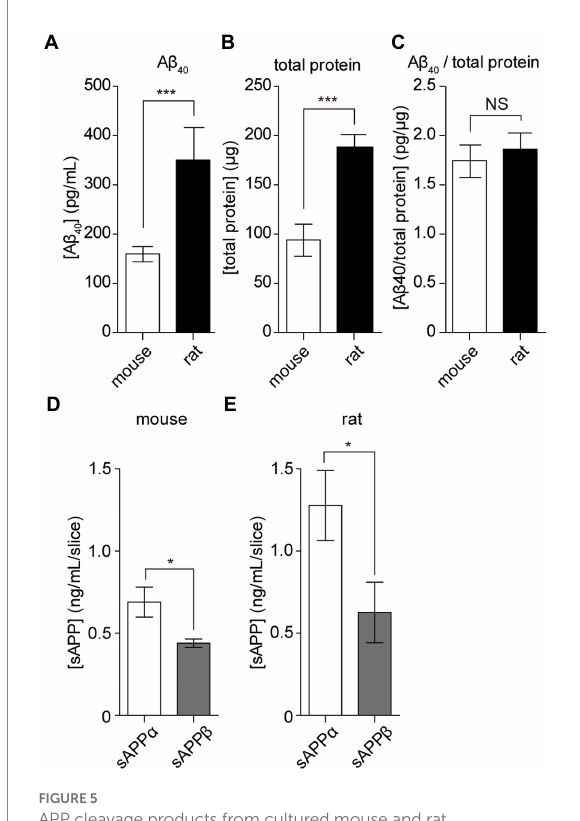
FIGURE 5 APP cleavage products from cultured mouse and rat hippocampal slices. A β 40 , sAPP α , and sAPP β in SCM were quantified using ELISA. Four hippocampal slices were prepared from rats or mice plated on a filter membrane cup. (A) Quantification of A β 40 secreted from hippocampal slices (15 days in vitro ) cultured with fresh SCM for 24 h at 37 ° C. (B) Total protein levels in rat and mouse hippocampal slices. (C) Calculated data for the ratio of A β 40 to total protein ratio. (D,E) Quantification of sAPP α and sAPP β secreted from hippocampal slices cultured in fresh SCM for 24 h at 37 ° C. Statistical significance was determined using unpaired t -tests. NS; p > 0.05; *; p < 0.05; ***; p < 0.001. Data are presented as mean ± SD, based on three independent cultures ( n =